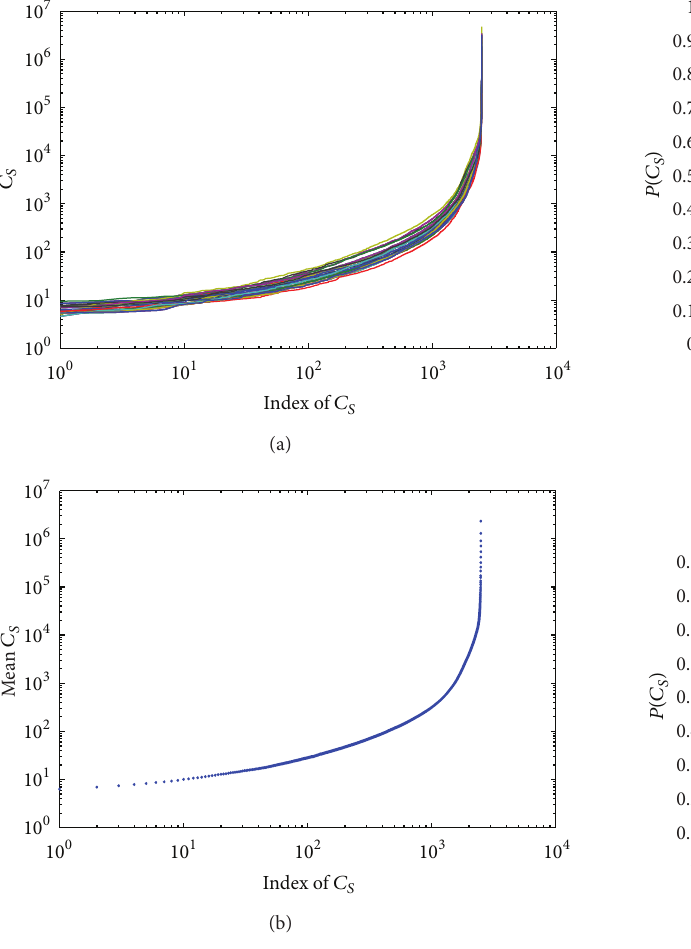
Figure 6: (a) Log-log plot of the subgraph centrality 𝐶 𝑆 (𝑖) in the BA scale-free network, (b) log-log plot of mean subgraph centrality (𝑖)⟩ in the BA scale-free network. ⟨𝐶 𝑆